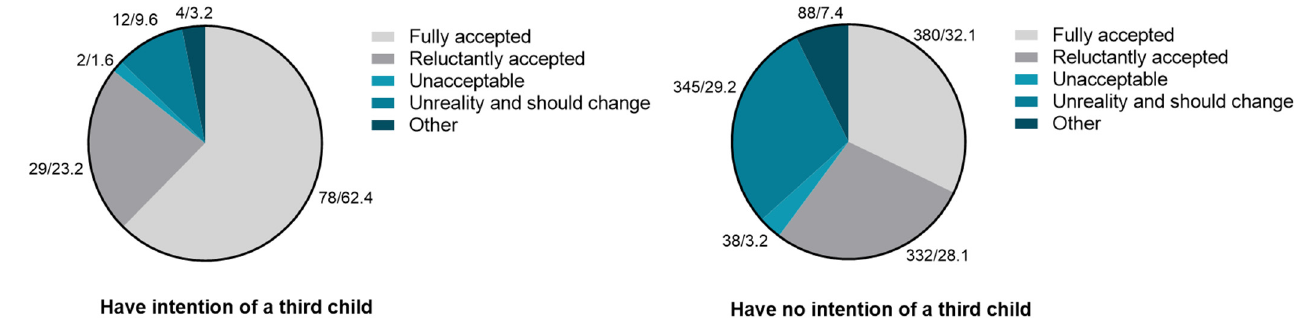
Figure 3. Public attitude toward the three-child policy.